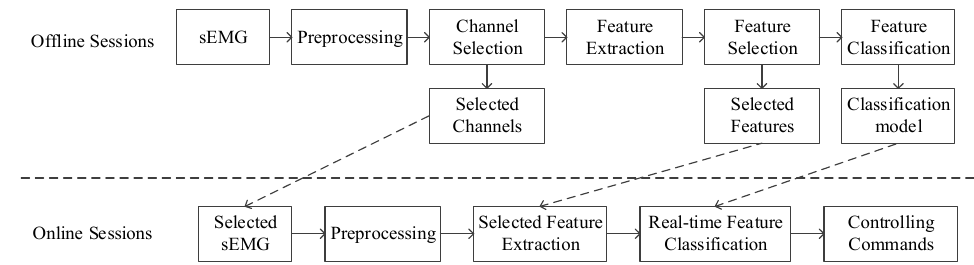
Figure 4. Flowchart of proposed processing framework.